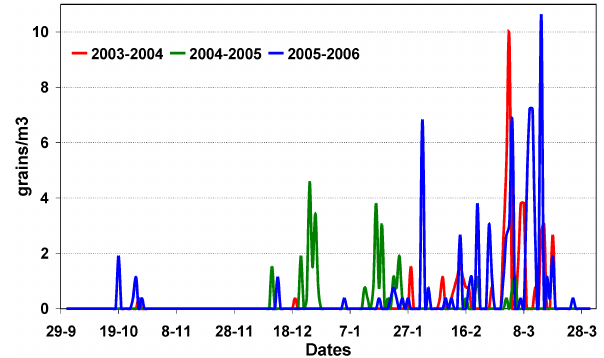
Fig. 1. Airborne pollen concentration of Weinmannia trichosperma in the air of Bariloche during three years of